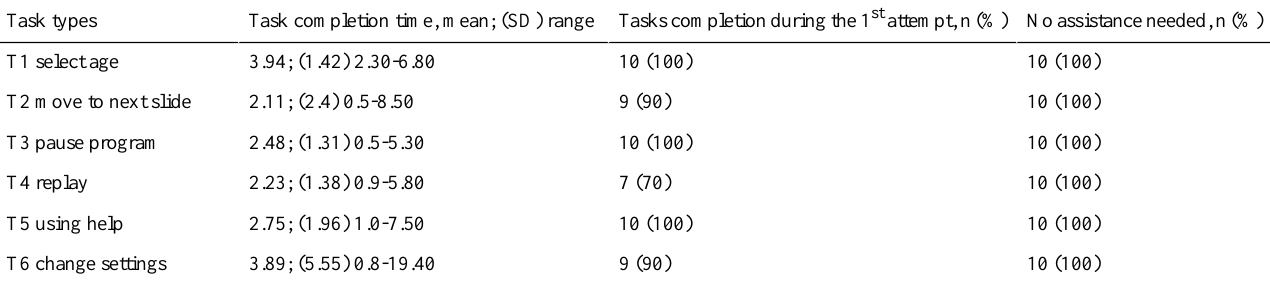
Table 3. Task completion times, attempts, and assistance needed to complete the tasks (N=10).